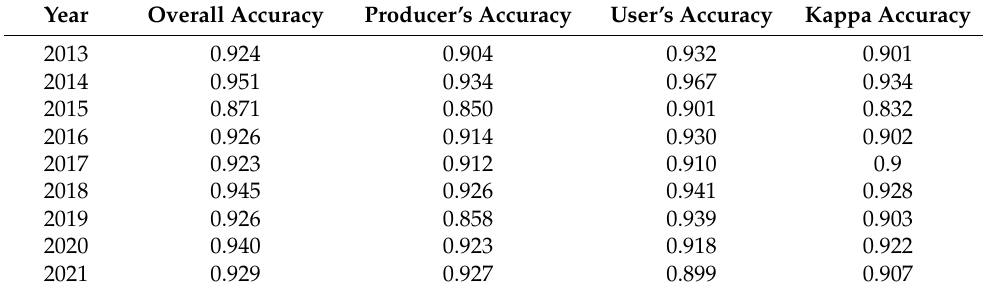
Table A3. Summary of accuracy values associated with the remote sensing interpretation of the marine cover in the study area .